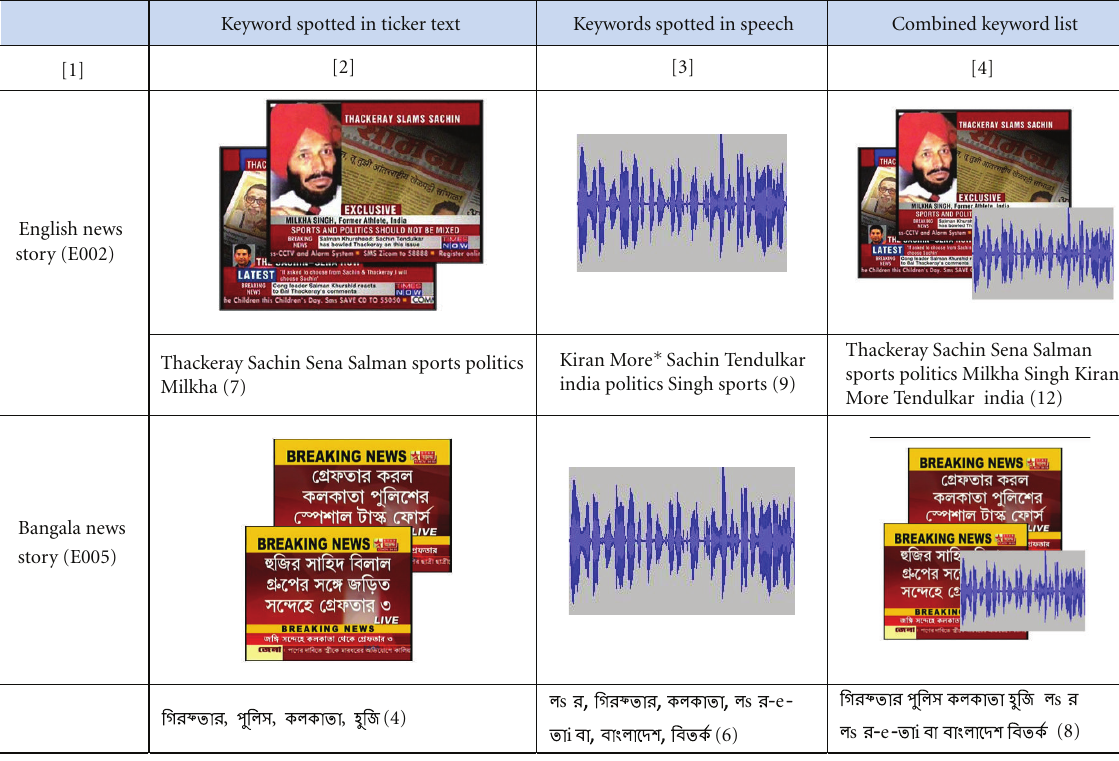
Figure 9: Combining audio and visual keywords for indexing. ∗ Kiran More: More (pronounced Mor´e) is a proper noun and not the English